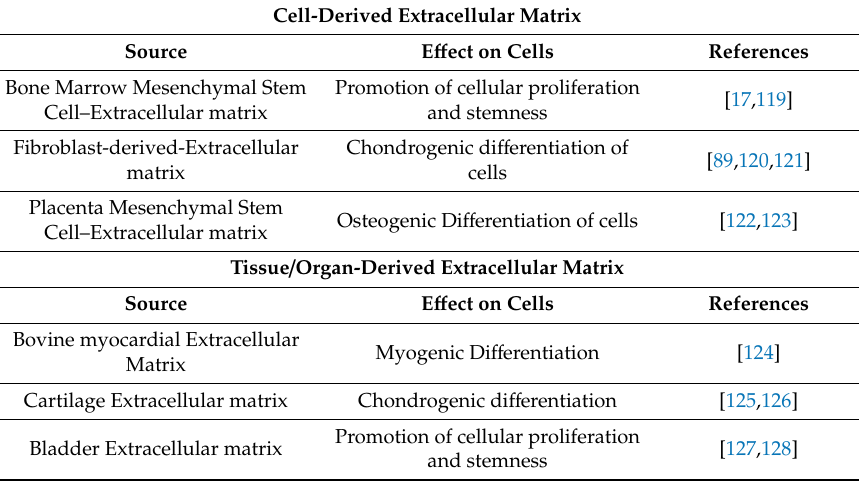
Table 2. Sources of cell-derived and tissue / organ-derived extracellular matrices and their e ff ects on cells. Cell-Derived Extracellular